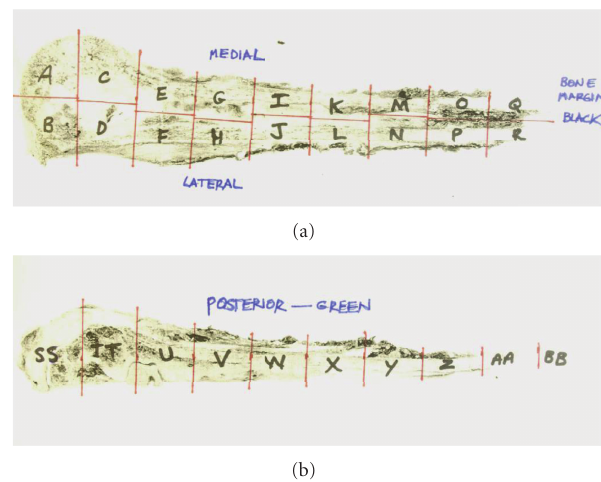
Figure 1: Fibrotic replacement of the marrow space occurred fol- lowing chemotherapy. There were small foci of residual disease grossly and histologically. Overall, systematic mapping of the resec- tion specimen is essential to measure the response to preoperative chemotherapy in the primary tumor (a). Anteroposterior view of the specimen mapped into block segments (b). This response was graded as good, with more than 90% necrosis (Grade 3, Huvos system; Grade 2, Picci